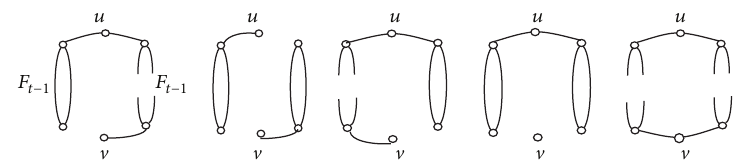
Figure 5: The number of spanning forests with two components of 𝐹 𝑡